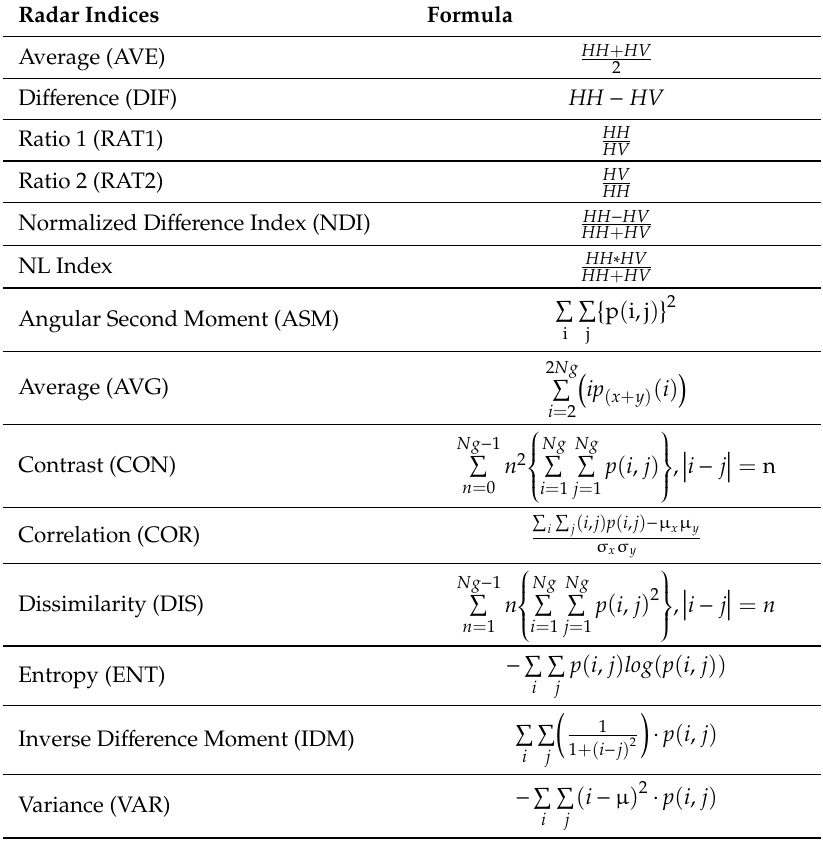
Table 2. Formulae of indices calculated from SAR